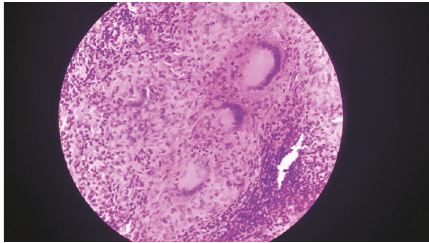
Figure 2: Histopathological picture showing epithelioid cells, Lang- hans cells, and foci of caseous